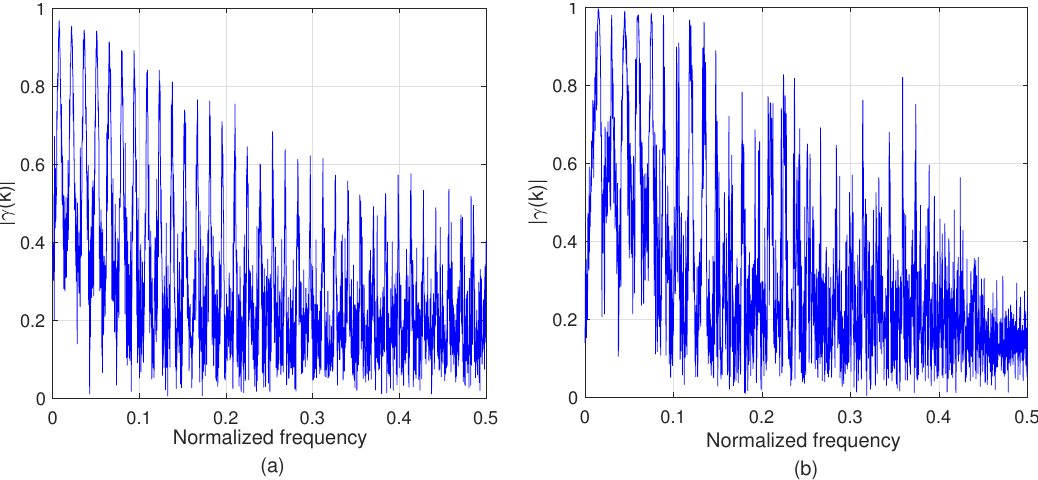
Figure 3. Coherence γ ( k ) when N = 4096, and M = 30: ( a ) signals generated by the channel model (27); ( b ) measured signals in the field test for Location 3 and sensors 1 and 3